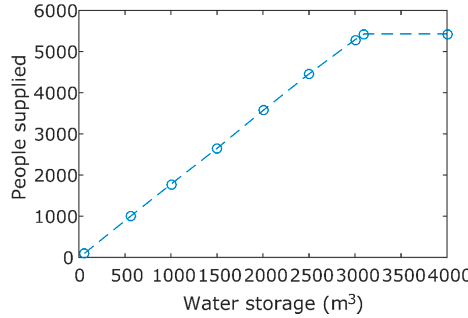
Figure 9. Population size the system can supply as a function of water storage size.